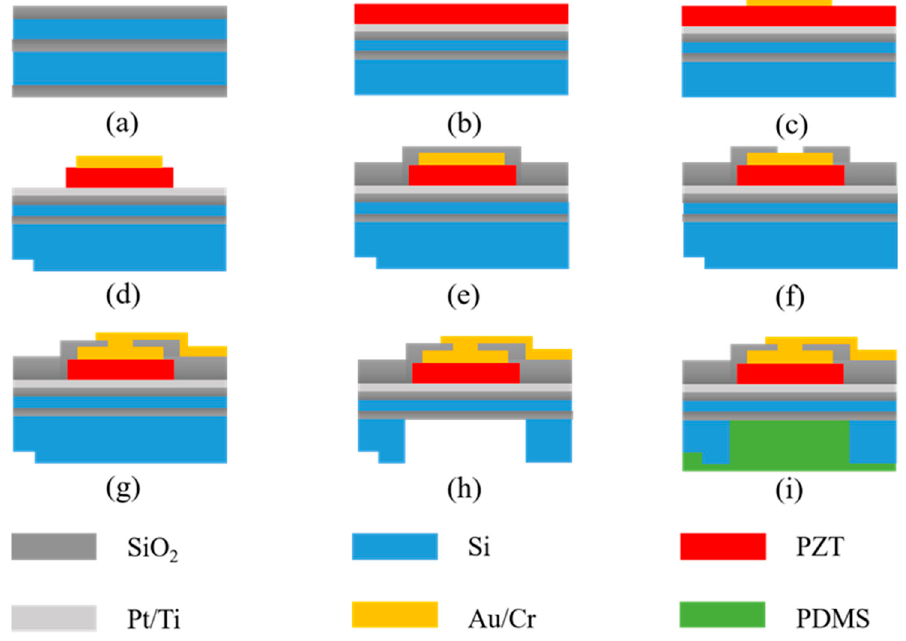
Figure 2. ( a – i ) The fabrication process of the